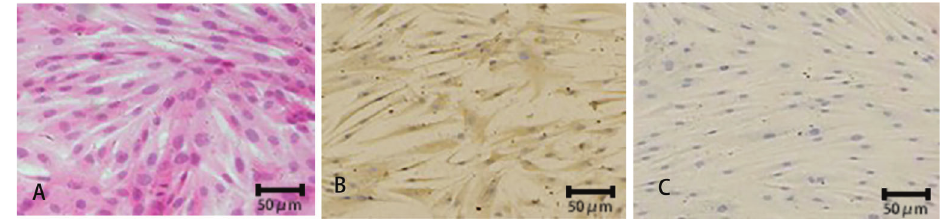
Figure 1 . Characterization of human periodontal ligament fi broblasts (HPDLFs). H&E staining ( A ) and immunocytochemical staining for vimentin ( B ) and keratin ( C ) were performed in HPDLFs. Representative images are